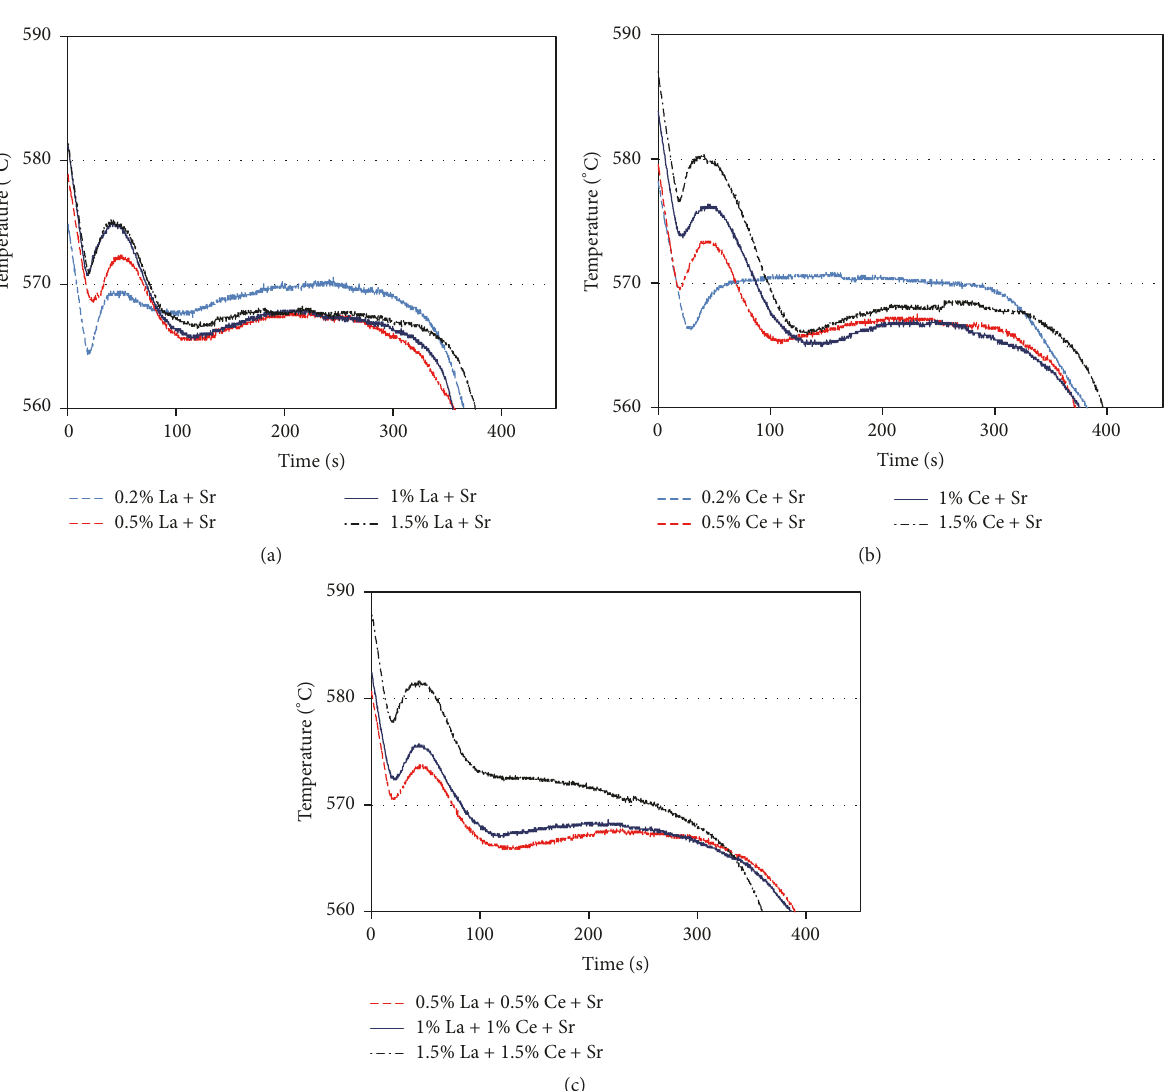
Figure 5: Temperature-time curves obtained from the modified base alloy with various concentrations of (a) La, (b) Ce, and (c) La + Ce.